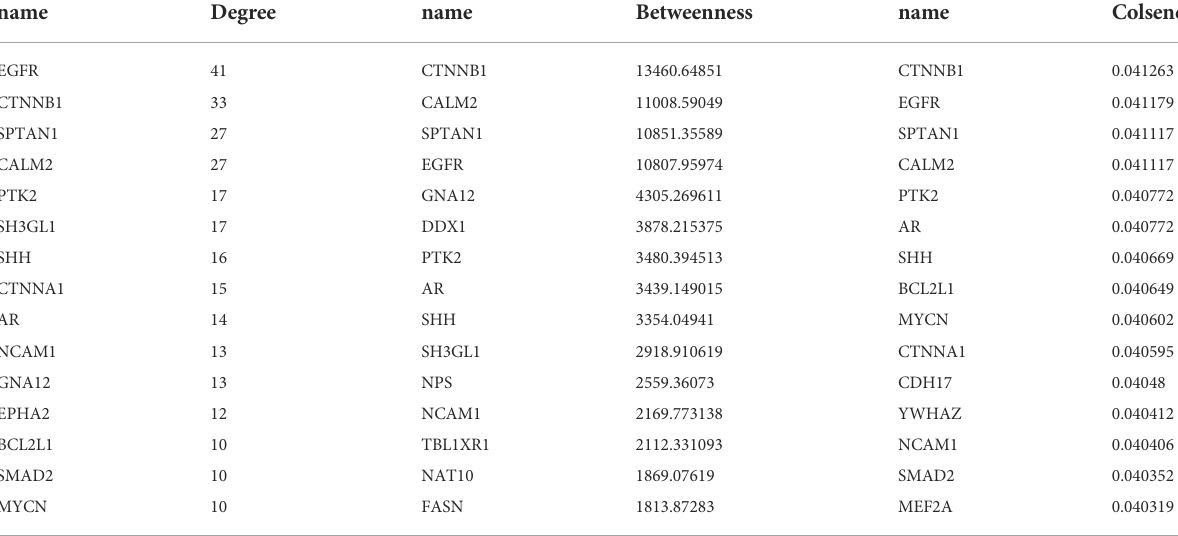
TABLE 3 The top 10 hub nodes in the protein – protein interaction